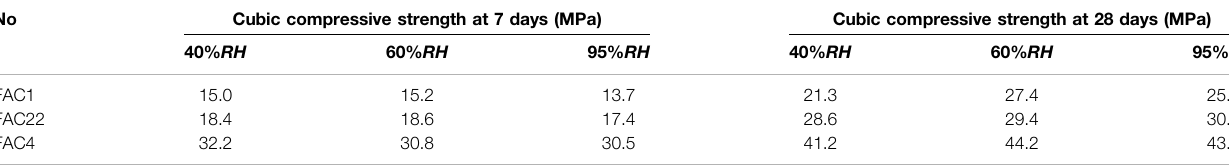
TABLE 6 | Cubic compressive strength of FAC affected by relative humidity of the curing room. No Cubic compressive strength at 7 days (MPa) Cubic compressive strength at 28 days (MPa)